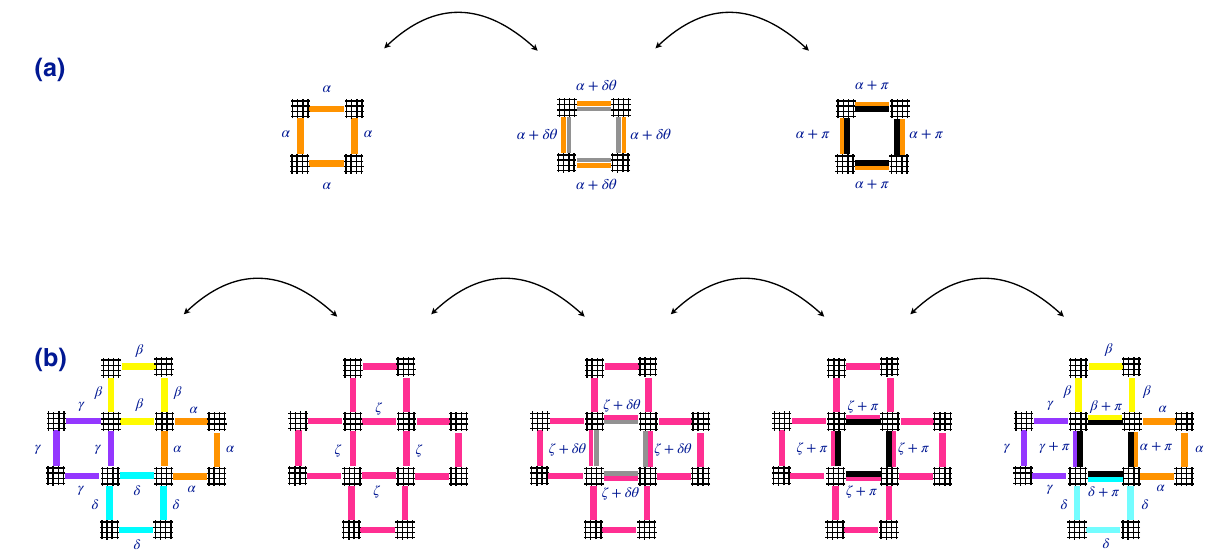
FIG. 6. Two types of elementary plaquettes with different plaquette flipping matrix elements. These two types appear as a conse- quence of the crystal of small loops shown in Fig. 4. In (a) the plaquette contains the elementary U ( 1 ) phase variable loop, in which all four phases on the edges are equal to some common angle α . In (b) the plaquette is surrounded by four elementary U ( 1 ) phase loops, with four different angles α , β , γ , and δ along the edges. In both cases adding π to each leg around the plaquette costs no Josephson energy. The intermediate steps illustrate the path for which one goes from the initial to the final configuration without incurring any Josephson energy